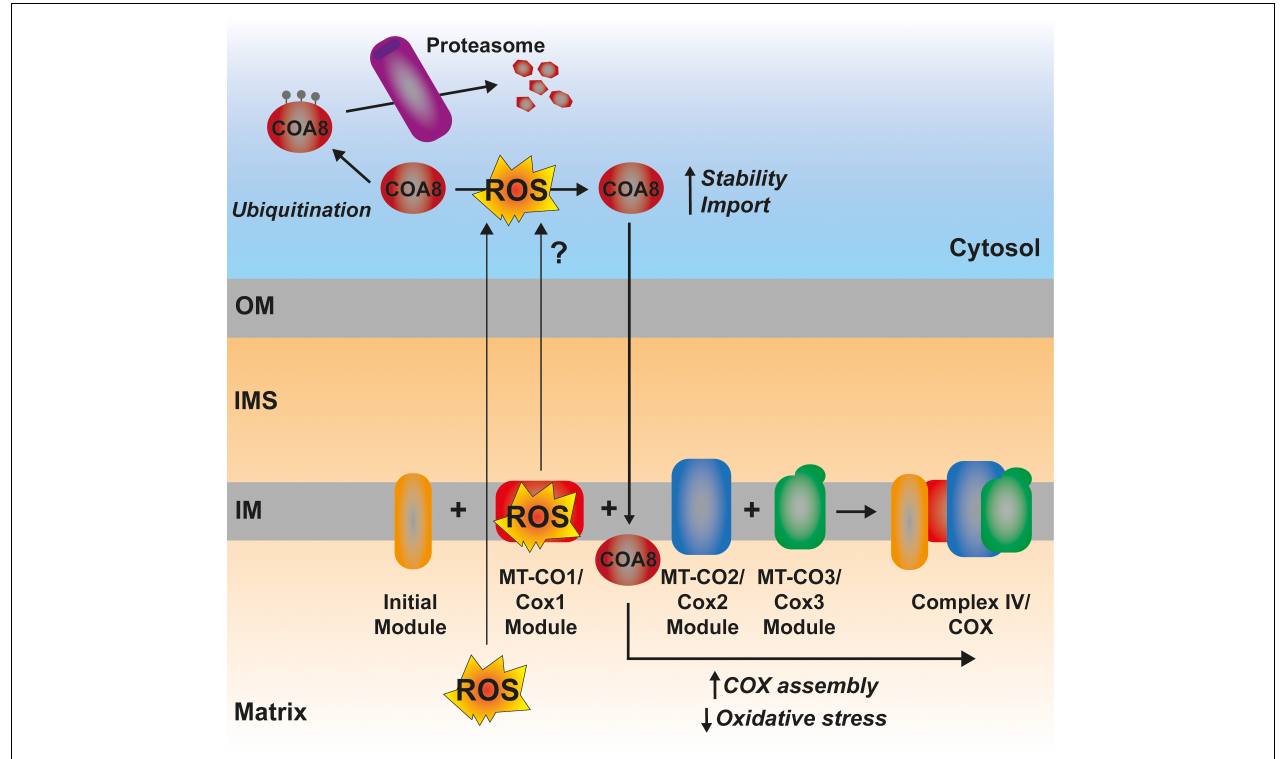
FIGURE 6 | Possible mechanism of ROS-mediated CIV assembly regulation by COA8. The ROS produced by a hemylated partially assembled MT-CO1 could represent a signal triggering the increased import and/or stabilization of COA8, promoting CIV assembly and, thereby, reducing oxidative stress.